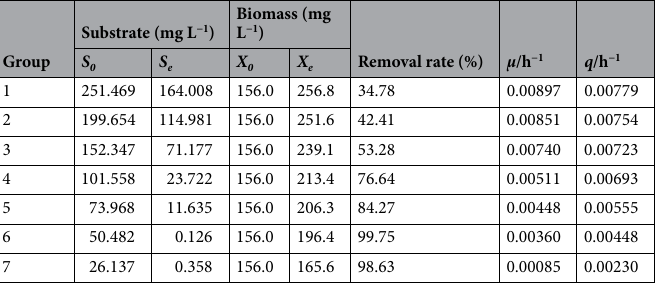
Table 1. Changes of μ , q and removal rate of aromatic VOCs under different initial